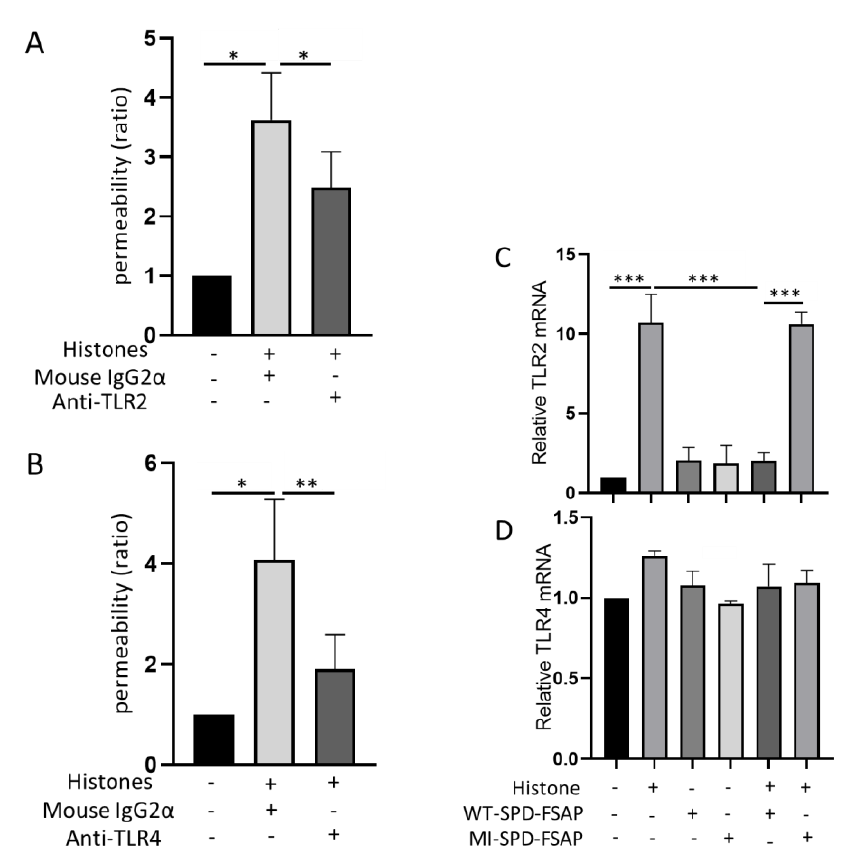
Figure 4. Role of SPD-FSAP in the overexpression of TLR4 induced by histones. ( A , B ) Permeability induced by histones was decreased significantly by antibodies against both TLR2 and TLR4. ( C ) Quantitative RT-PCR showed that TLR2 mRNA expression was strongly increased by histones. WT–SPD–FSAP abolished this effect, while MI–SPD–FSAP did not. ( D ) TLR2 mRNA expression was not influenced by histones and/or WT–SPD–FSAP. Data are presented as mean ± SEM; n = 3, * p < 0.05, ** p < 0.01, and *** p < 0.001. N represents 3 independent experiments, with 3 replicates in each